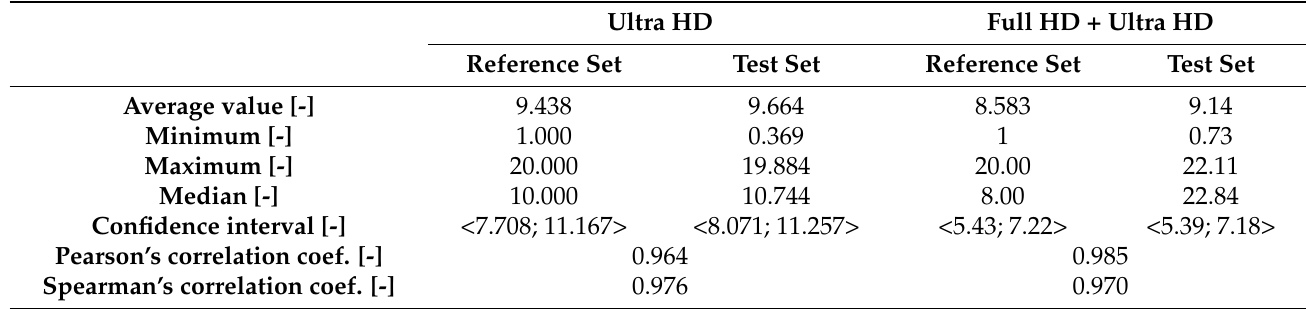
Table 11. Descriptive statistics for bitrate prediction based on SSIM, H.264 +